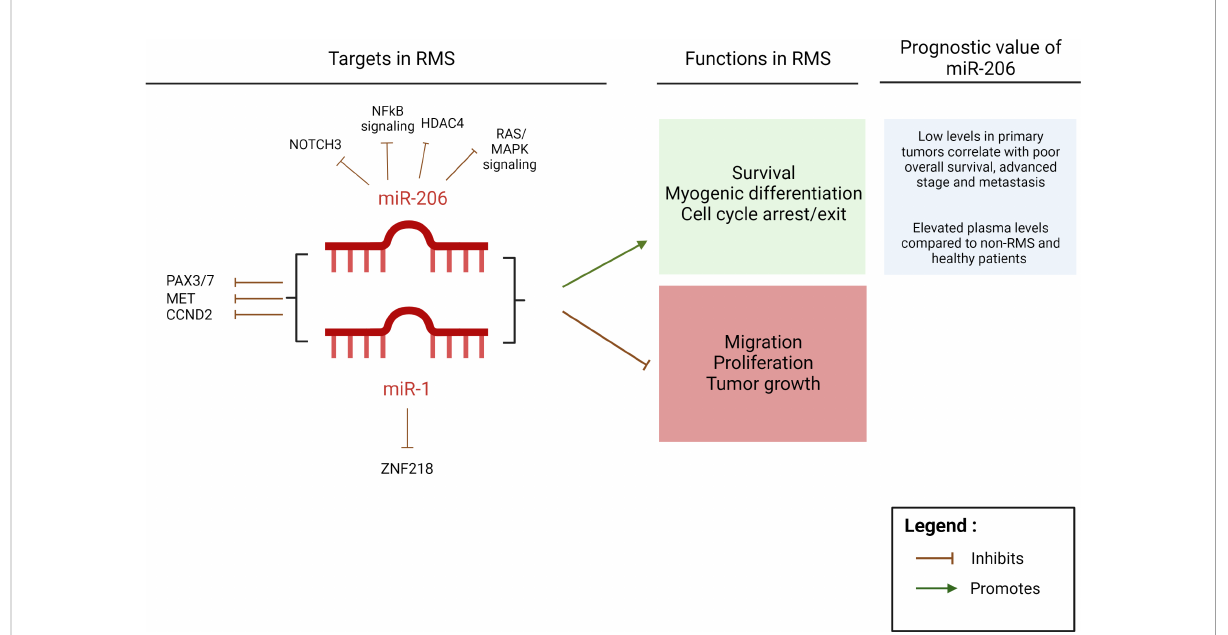
FIGURE 2 miR-1 and miR-206 targets and functions in RMS. Schematic diagram of miR-1 and miR-206 common and unique targets that have been demonstrated in RMS, and their functions and the prognostic value of miR-206 in RMS. Created with